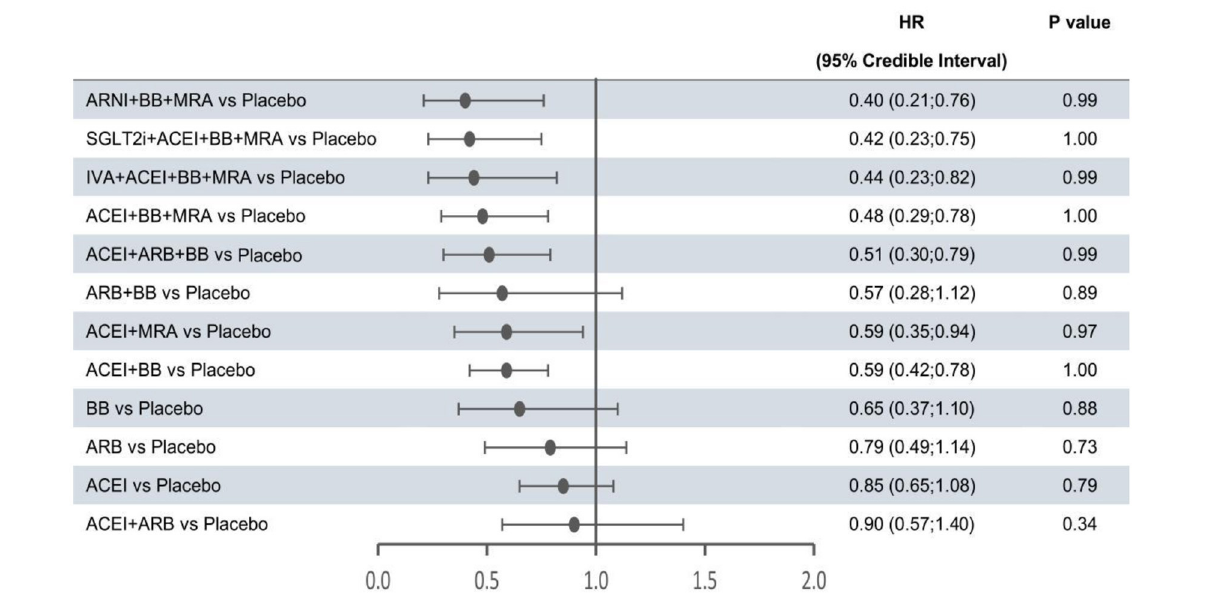
shown in Figure 3 , the trend of point estimates for cardiovascular mortality was similar to that for all-cause mortality. Nevertheless, the probability that monotherapies were better than